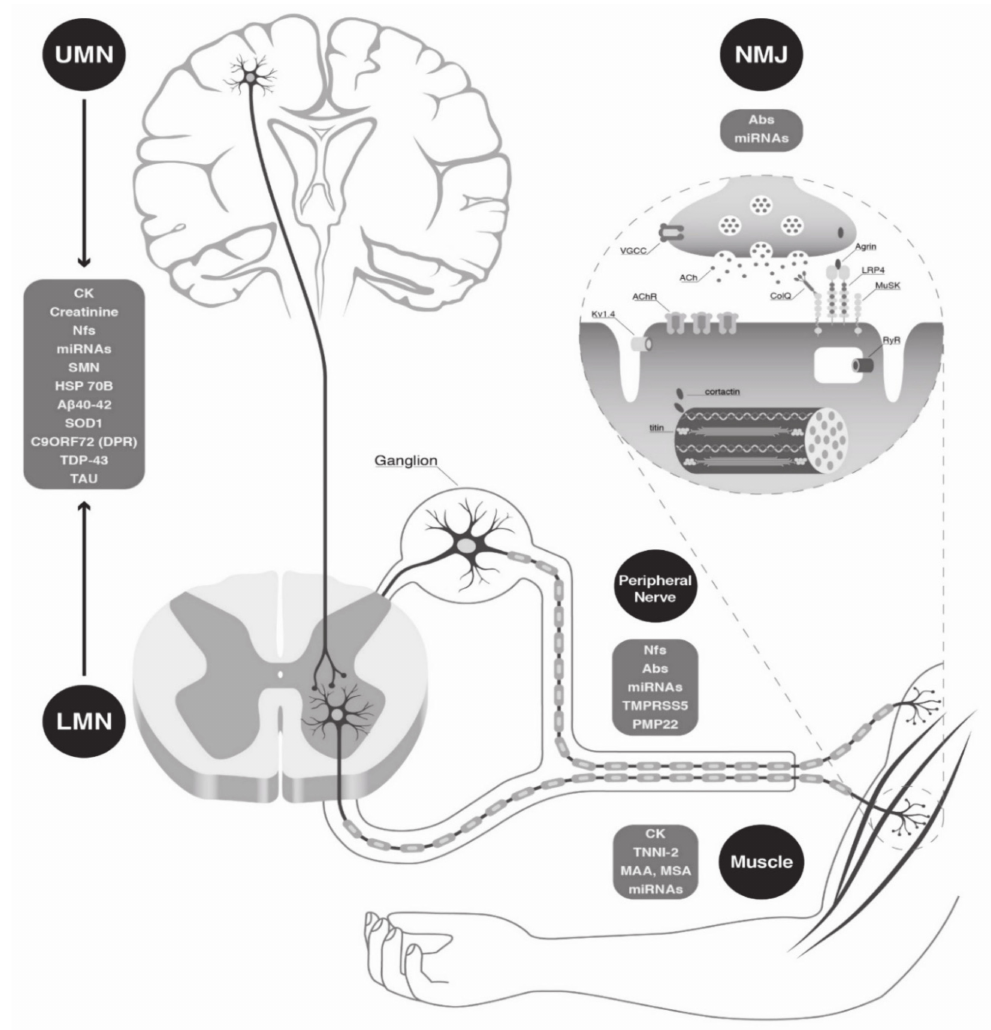
Figure 1. Main components of the neuromuscular unit and related biomarkers. Schematic representation of each part of the neuromuscular unit (upper motor neuron, lower motor neuron, neuromuscular junction and muscle) and of the main related circulating biomarkers. Abbreviations: Abs, antibodies; A β 40-42, Amyloid- β 40-42; AchR; CK, creatine kinase; DPR, dipeptide repeat; HSP70B, heat shock 70 kDa protein 7; LMN, lower motor neuron; NMJ, neuro muscular junction; MAA, myositis-associated Abs; miRNAs, microRNAs; MSA, myositis-specific Abs; PMP-22, peripheral myelin protein 22; Nf, neurofilament; SMN, survival motor neuron; SOD1, superoxide dismutase 1; TAR DNA-binding protein 43 (TDP-43); TMPRSS5, transmembrane protease serine 5; TTNI, serum troponin; UMN, upper motor